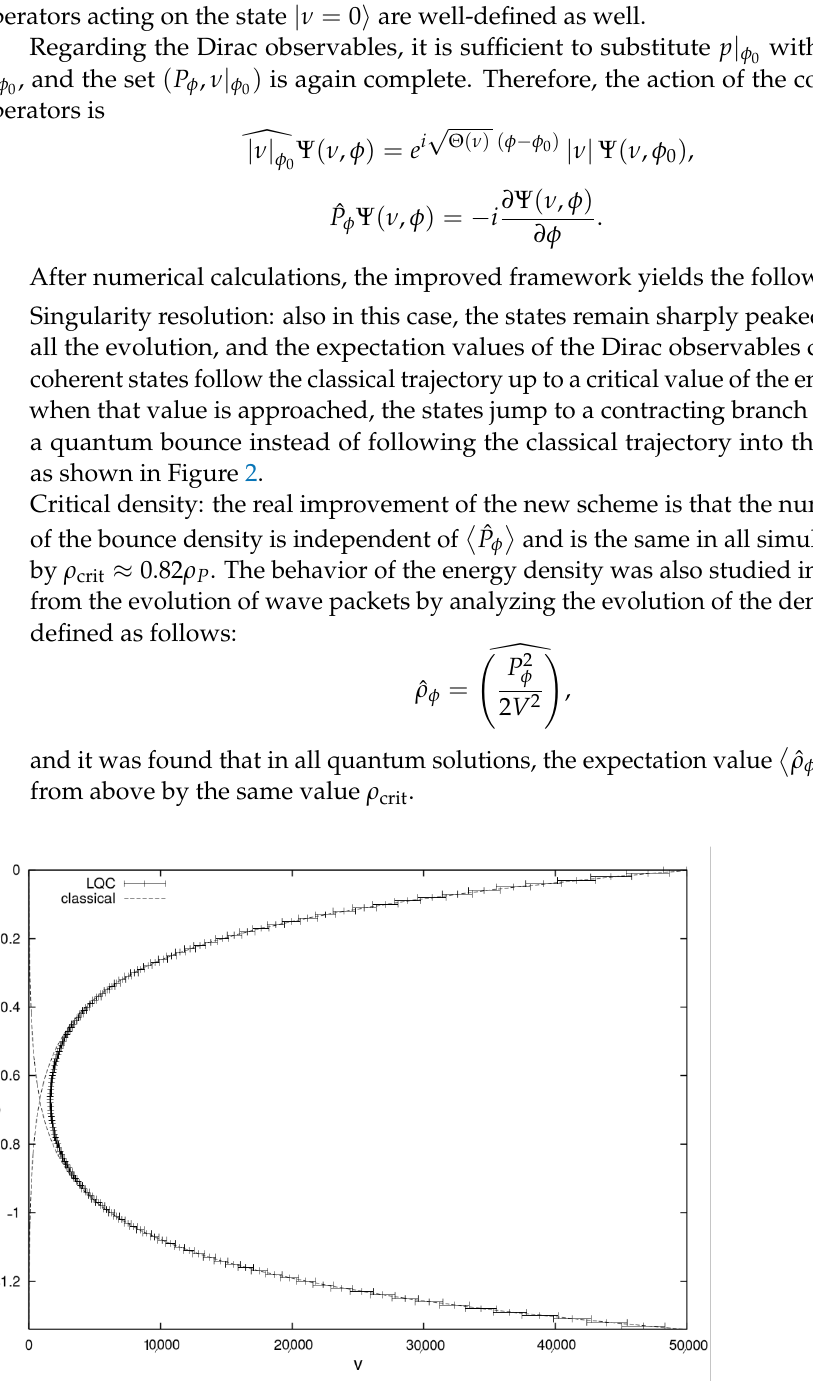
Figure 2. Expectation values and dispersion of v as function of time ϕ (horizontal bars) for a coherent state, compared with the classical trajectories (dashed lines). Image from